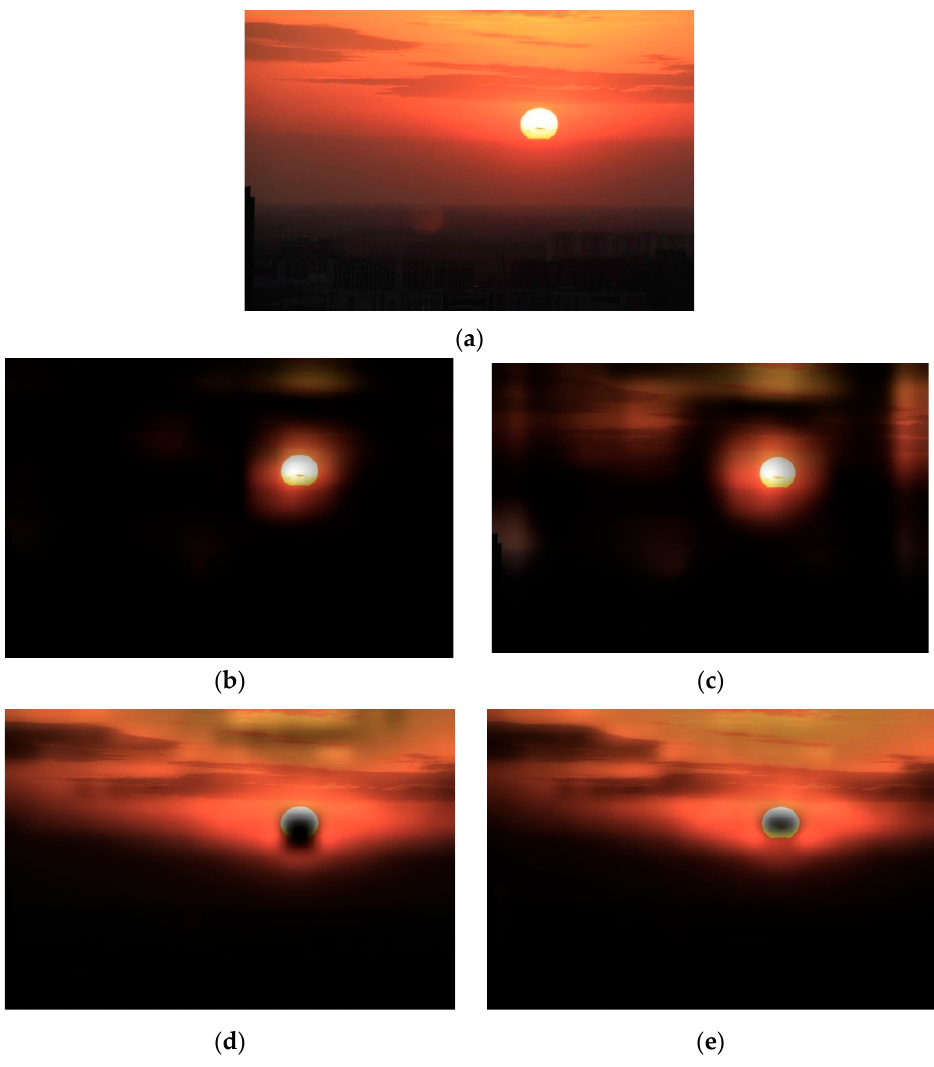
Figure 4. Examples of FFP and AIR. ( a ) Original image. ( b ) FFP by model A. ( c ) AIR by model A. ( d ) FFP by model B. ( e ) AIR by model B.